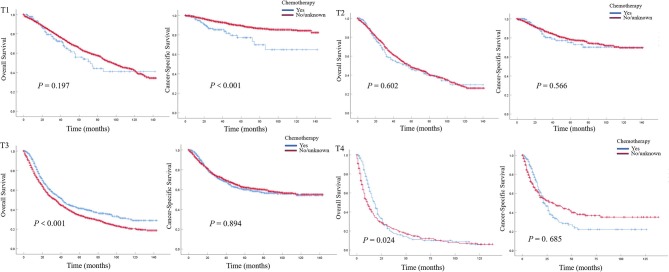
Kaplan–Meier plots depicting overall survival (OS) and cancer-specific survival (CSS) for pT1, pT2, pT3, and pT4 diseases, after stratification according to perioperative chemotherapy record in 7,278 patients treated with nephroureterectomy between 2004 and 2015, within the Surveillance, Epidemiology and End Results database.